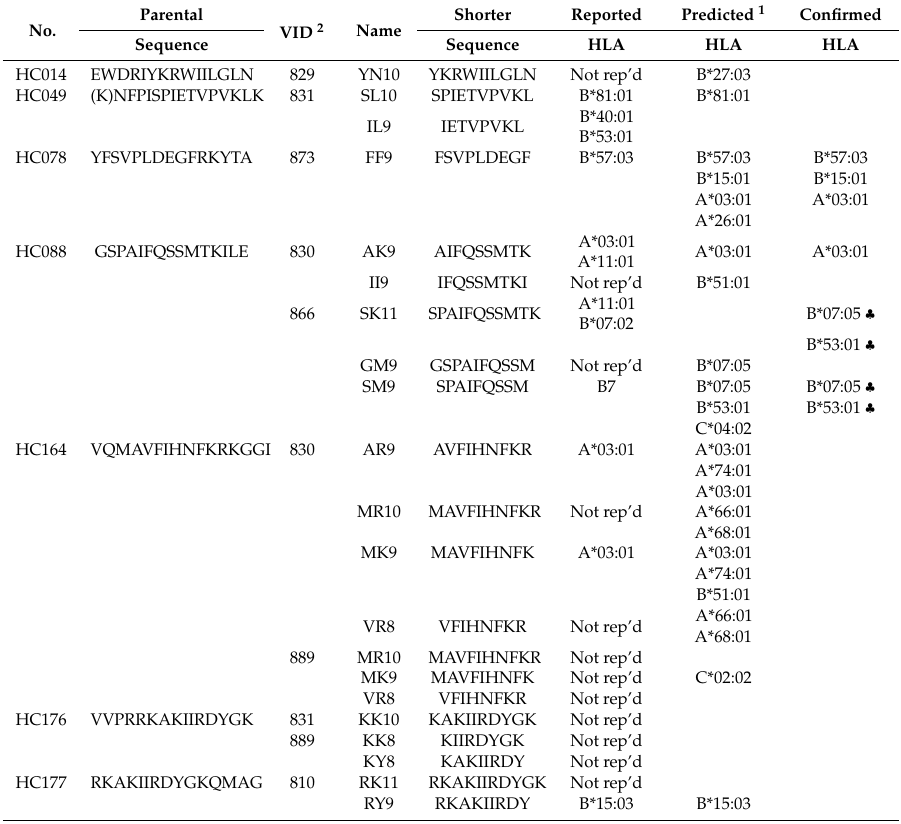
Table 1. Summary of stimulatory human leukocyte antigen (HLA) class I T-cell epitopes in the Nairobi